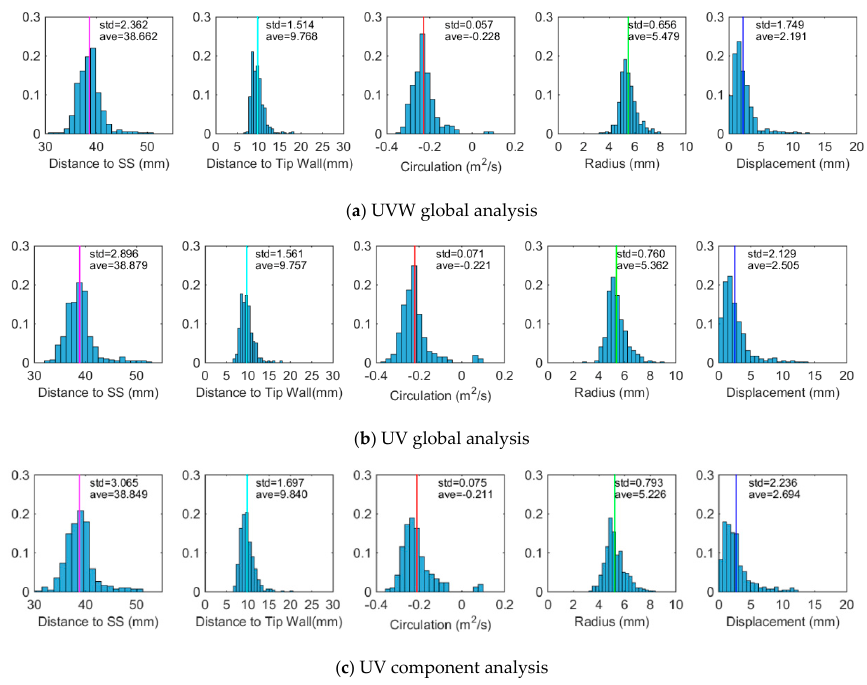
Figure 22 .Vortex distribution from reconstructed flow field using first 10 modes at L/c = 1.1.